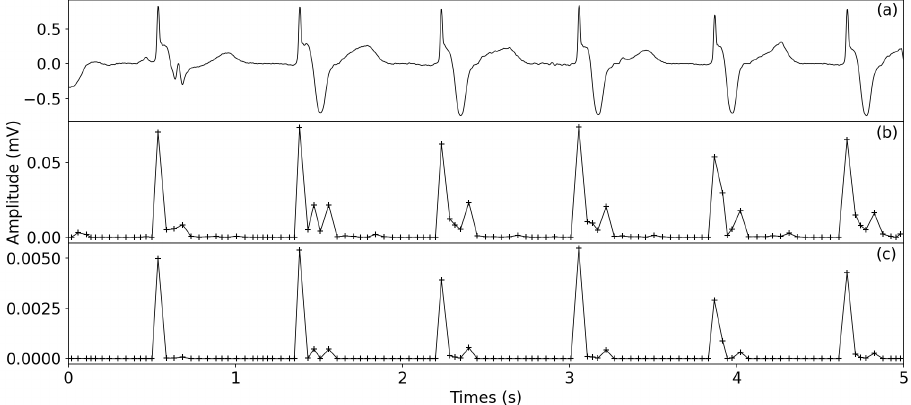
Figure 3. Comparison of original signal and the transformed signals, ( a ) Original signal of 104 from MIT-BIH database. ( b ) WVT—window variance transform signal. ( c ) SWVT—squared window variance transform